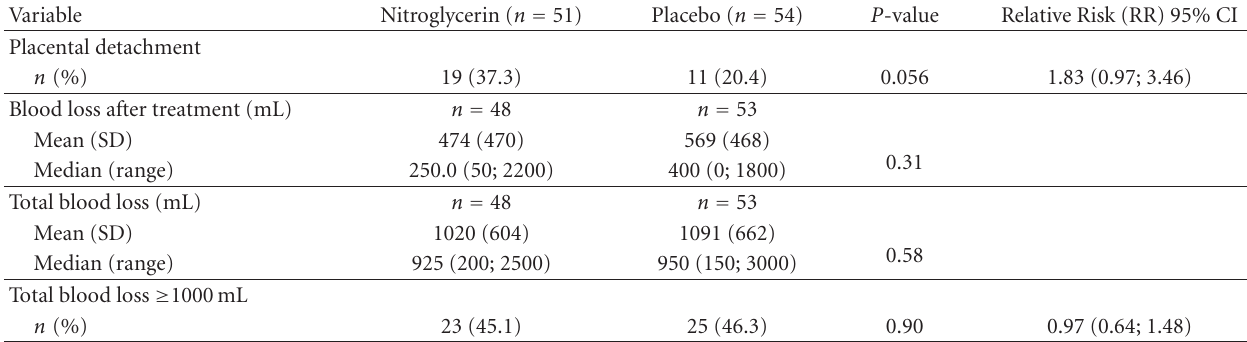
Table 3: Clinical data for management of retained placenta by treatment group (per protocol population, PP).